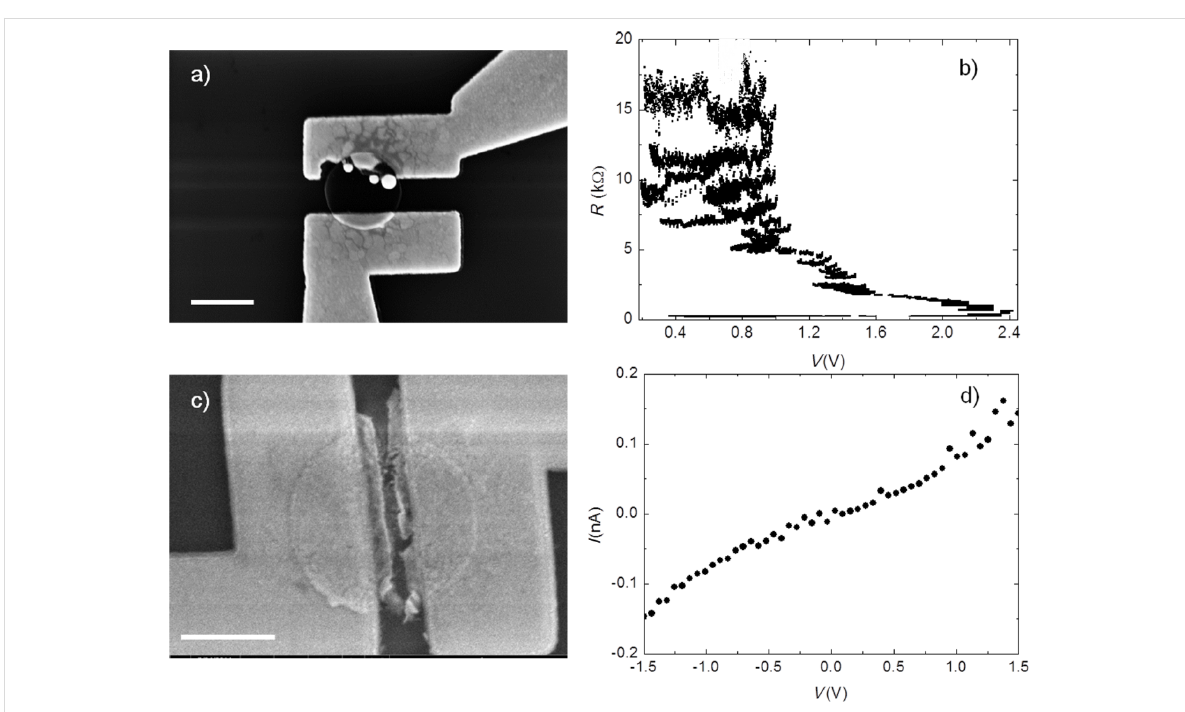
Figure 5: a) SEM image of a non-patterned disc after the EB process. During EB the area around the graphene–metal contact gets heavily damaged due to high power dissipation at these spots. b) EB cycle for a patterned TG disc (see text) showing the transition from low-ohmic ( ≈ 200 Ω ) to high- ohmic ( ≈ 20 k Ω ) behavior, which indicates the opening of a gap. c) Corresponding SEM image showing intact metal contacts while a breaking is visible in the disc. d) I – V -characteristic of electroburned TG device. A tunneling current is visible, demonstrating the presence of an open gap in the range of a few nanometers only. The scale bar is always 1